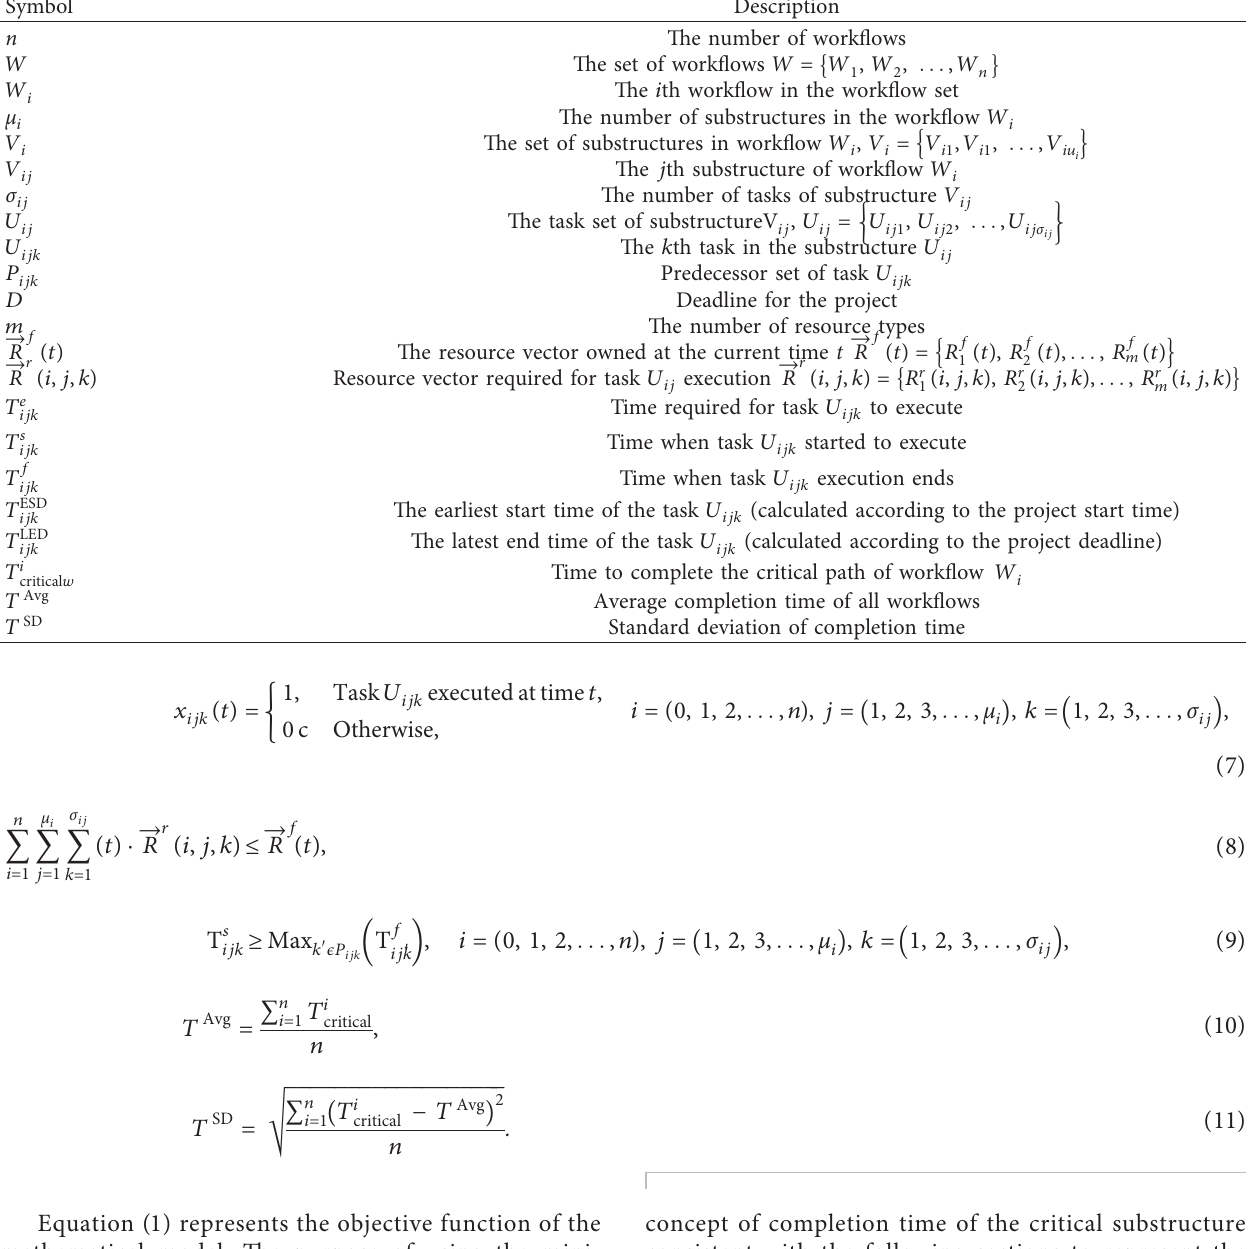
Table 2: Mathematical variable